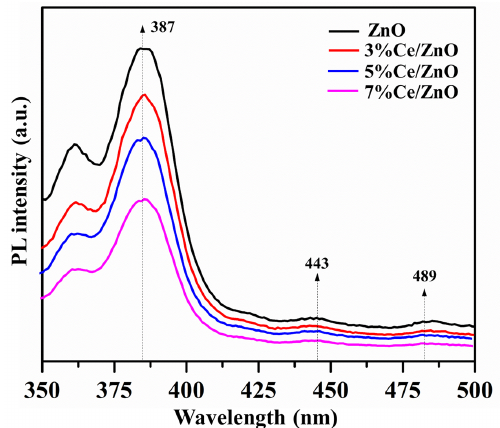
Figure 6. The photoluminescence spectra of the pristine ZnO and Ce/ZnO